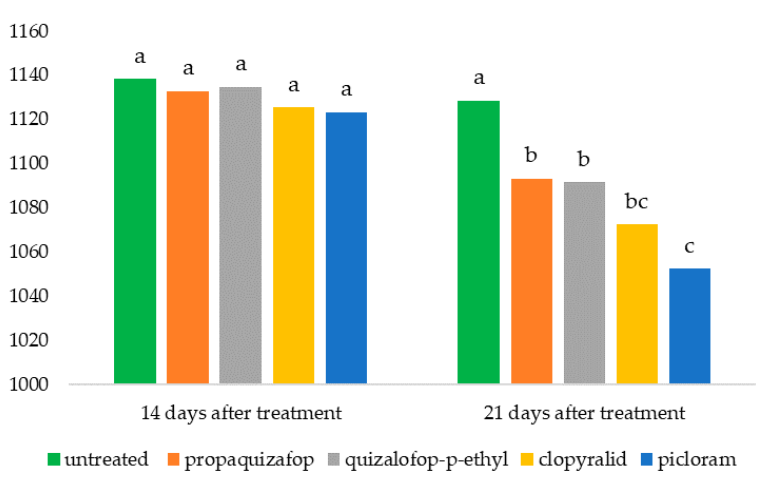
Figure 3. The effect of herbicides on Fm—maximum fluorescence (non-nominated units). Different letters ( a-c ) indicate statistically different mean LSD ( p < 0.05) 14 DAA = 23.80; LSD ( p < 0.05) 21 DAA = 32.17; DAA - days after herbicides aplication